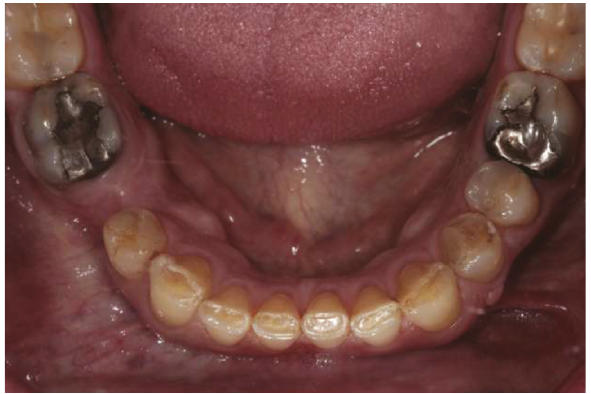
Figure 4: Mandibular occlusal